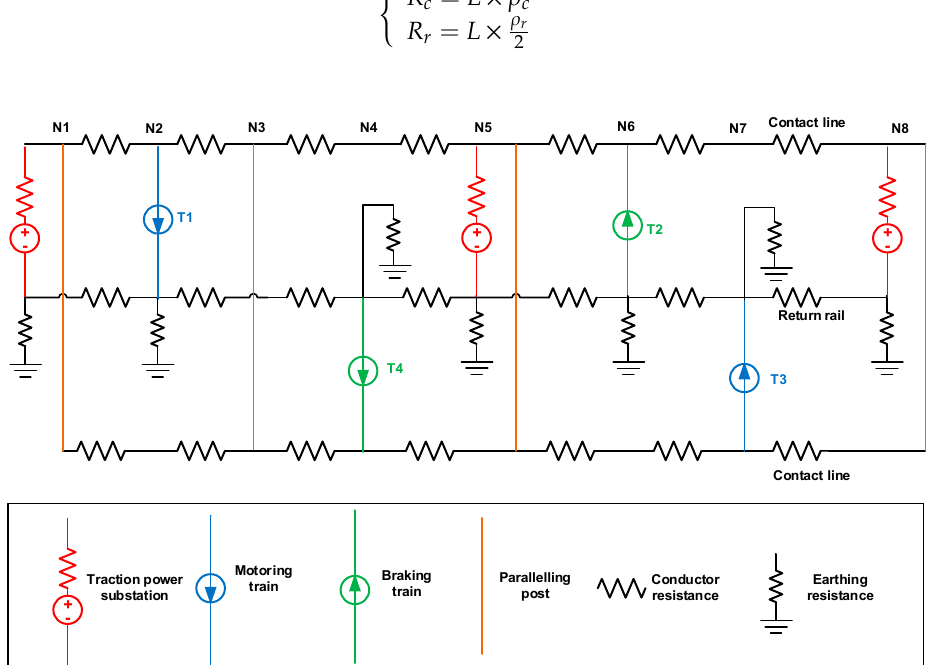
Figure 5. An equivalent circuit of the railway power network.